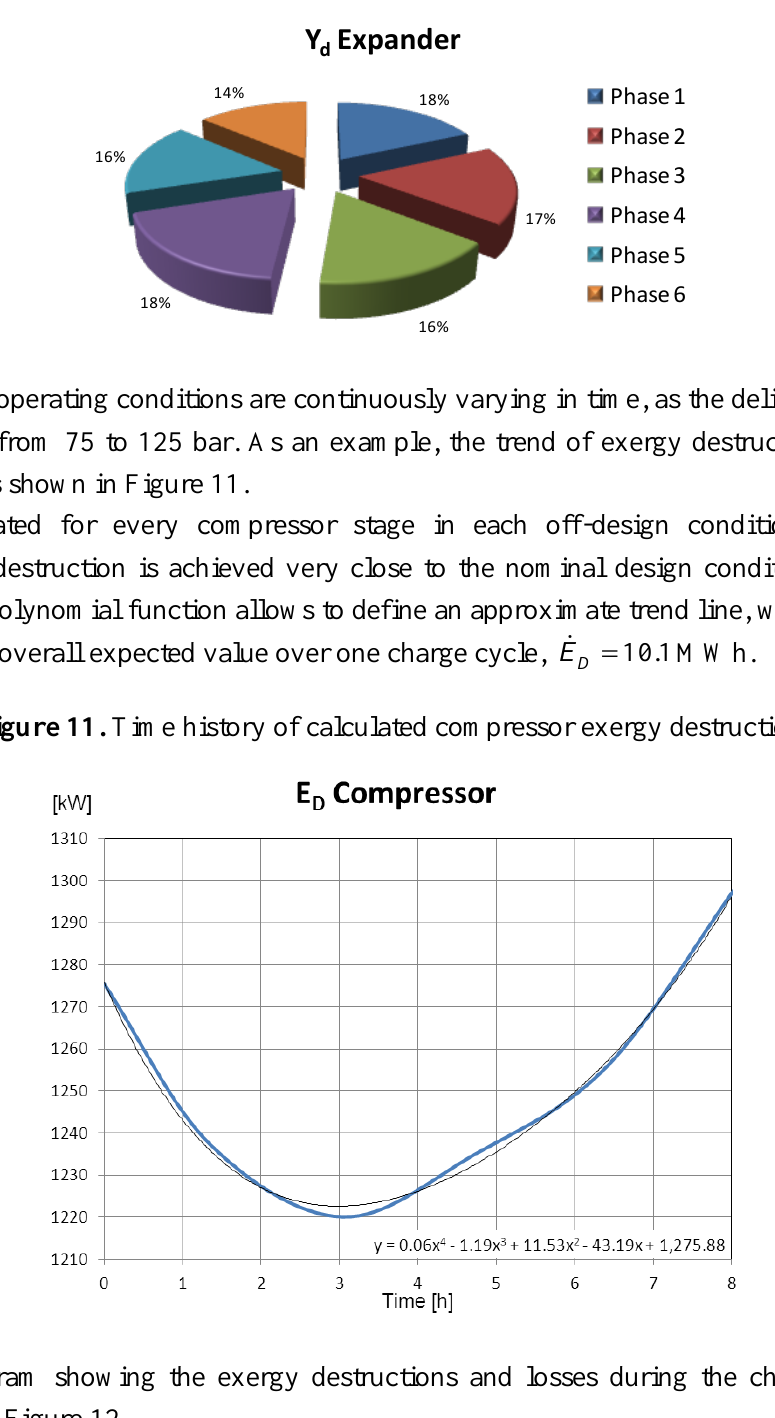
Figure 10. Relative distribution of expander exergy destruction ( p